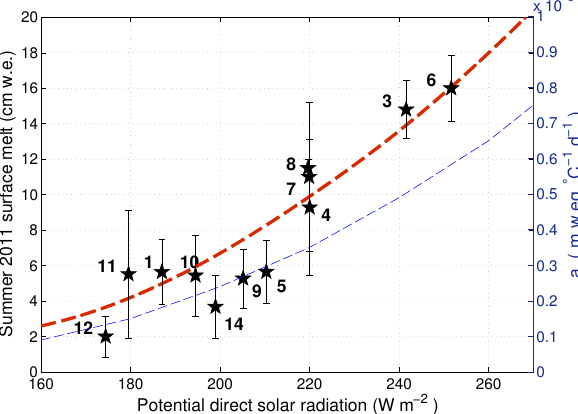
Fig. 10. Melt obtained from density anomalies (black stars) as a function of potential solar radiation, compared to melt obtained us- ing the surface energy balance model (red dashed line). Correspond- ing melt factor values in the degree-day model (Eq. 24) are plotted in blue.